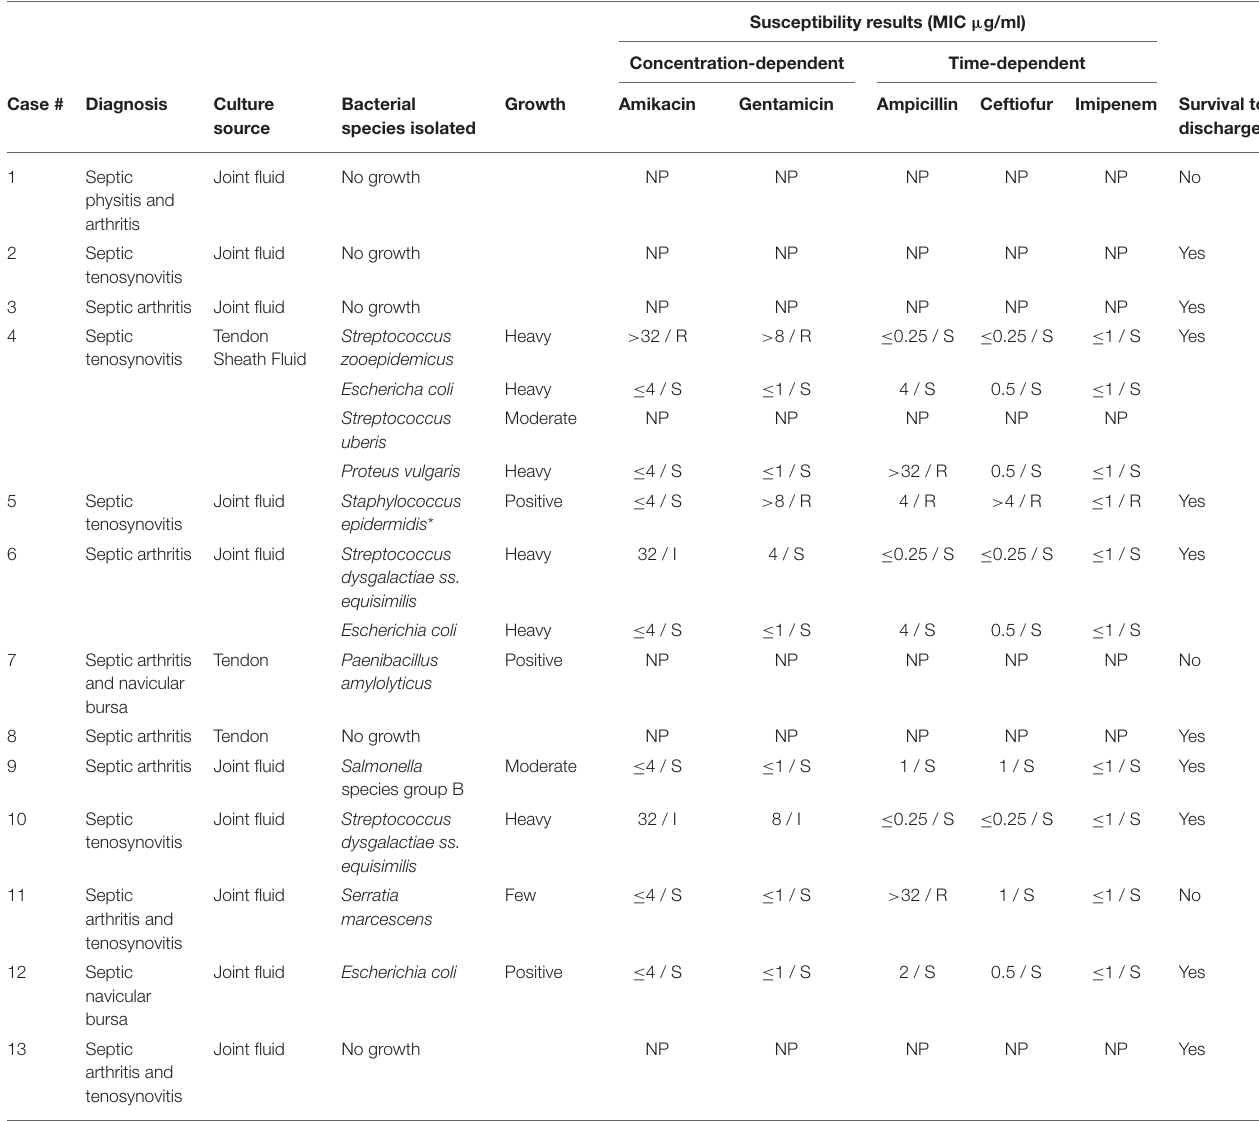
TABLE 5 | Bacterial culture and susceptibility results of horses treated with Gentamicin via intravenous regional limb perfusion with growth characteristics as reported by the